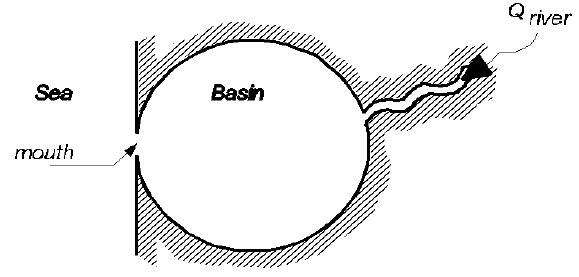
Figure A1. The conceptual model of the open delta.